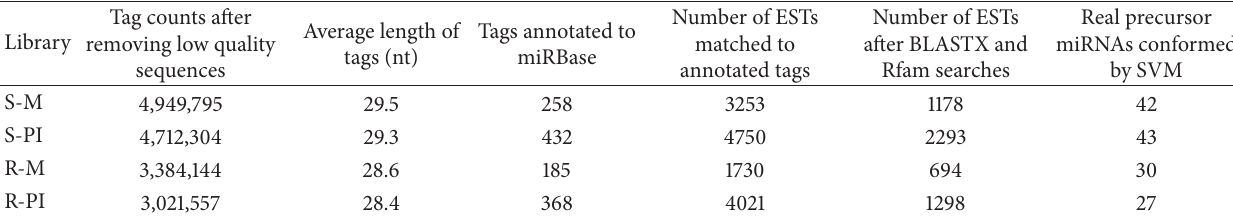
Table 1: Statistics of small RNA sequences in all four